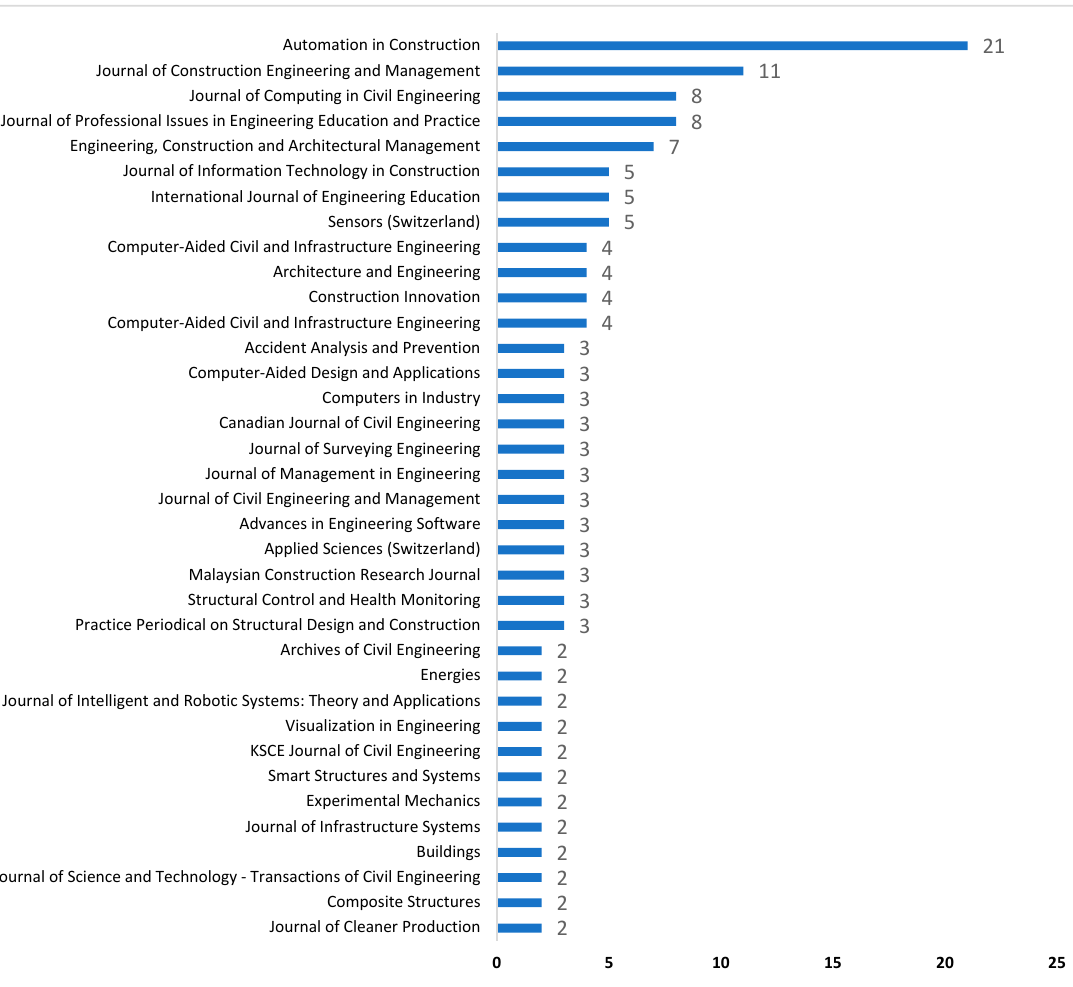
Figure 3. Journal Contributions.